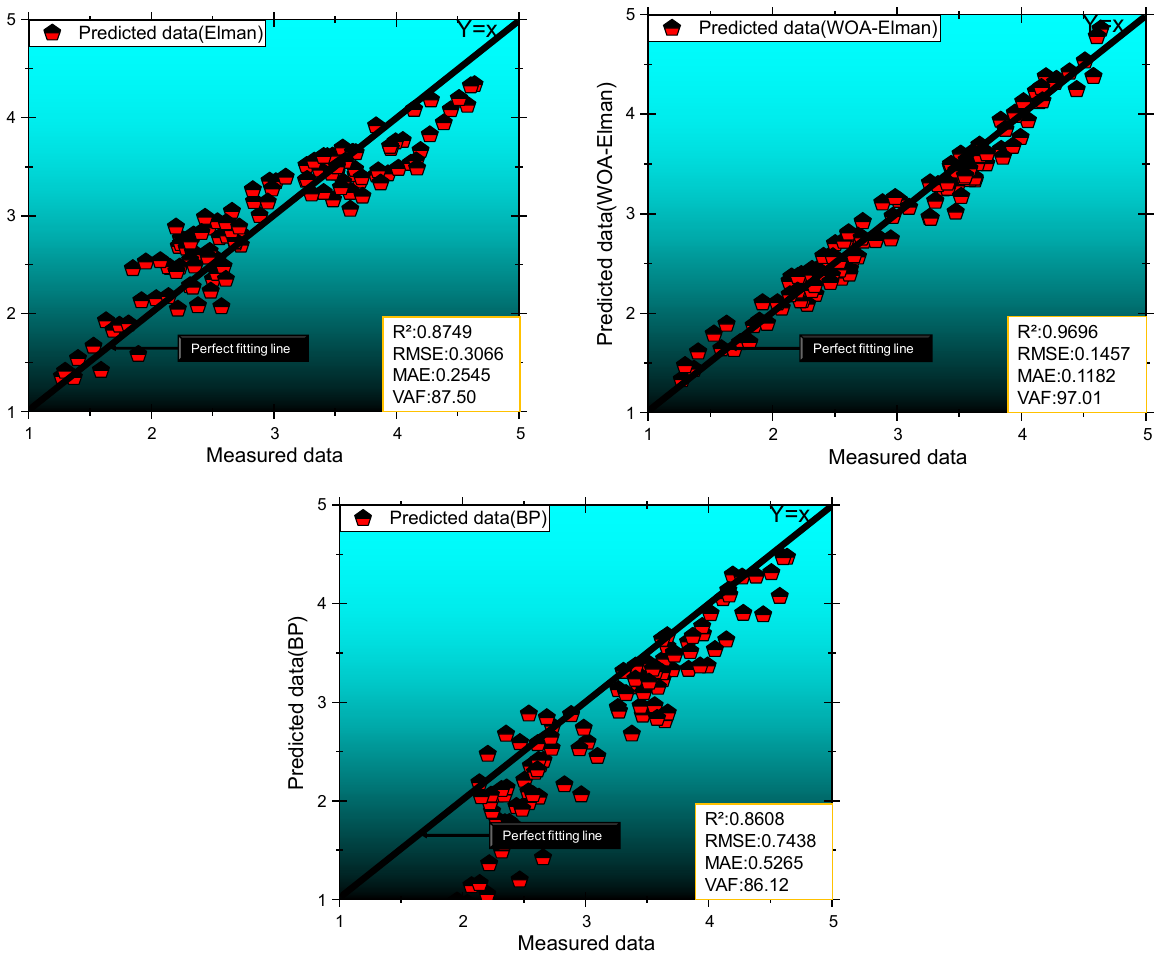
Figure 7. Correlation and error analysis between predicted value and real value of three machine learning models based on test set.